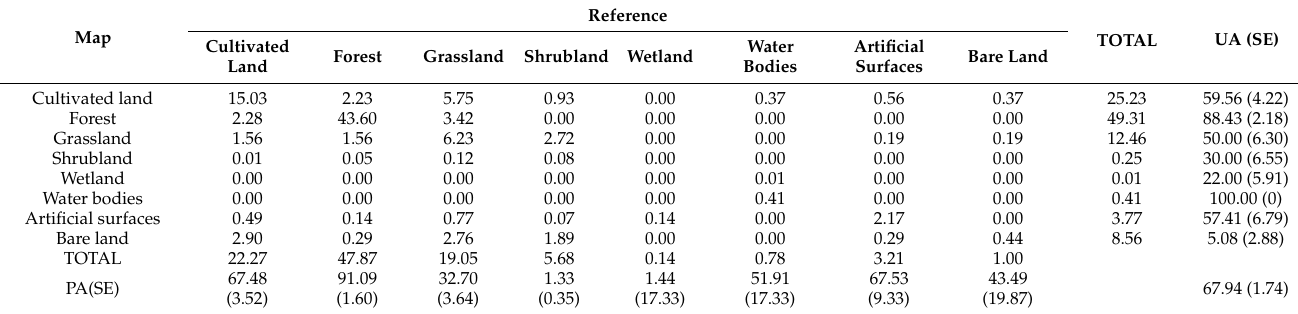
Table A7. Error matrix of GLC_FROM 2020.